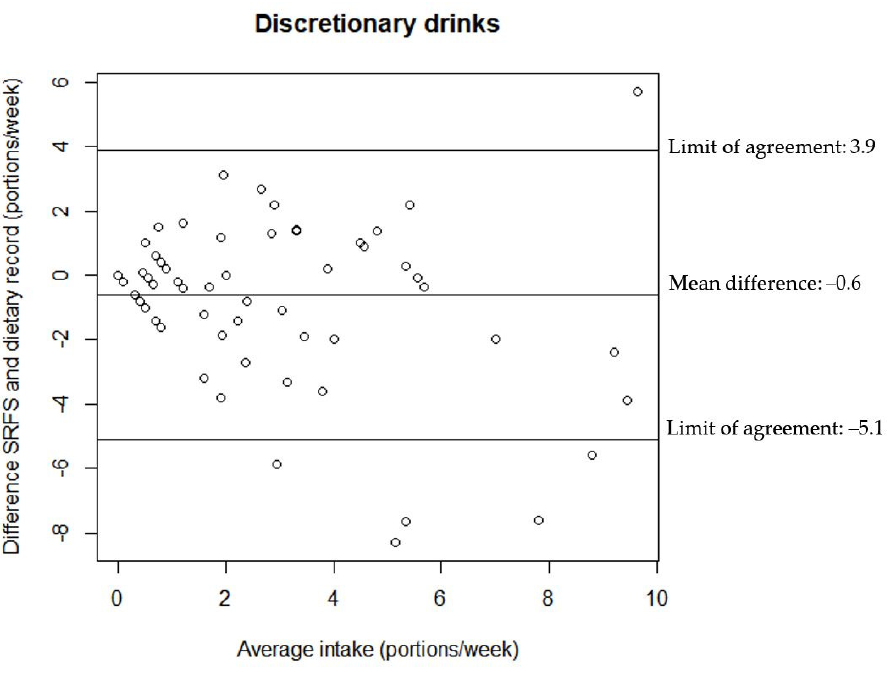
Figure 3. Agreement between the estimated portion intake of discretionary foods from the SRFS and the 7-day dietary record ( n = 80).